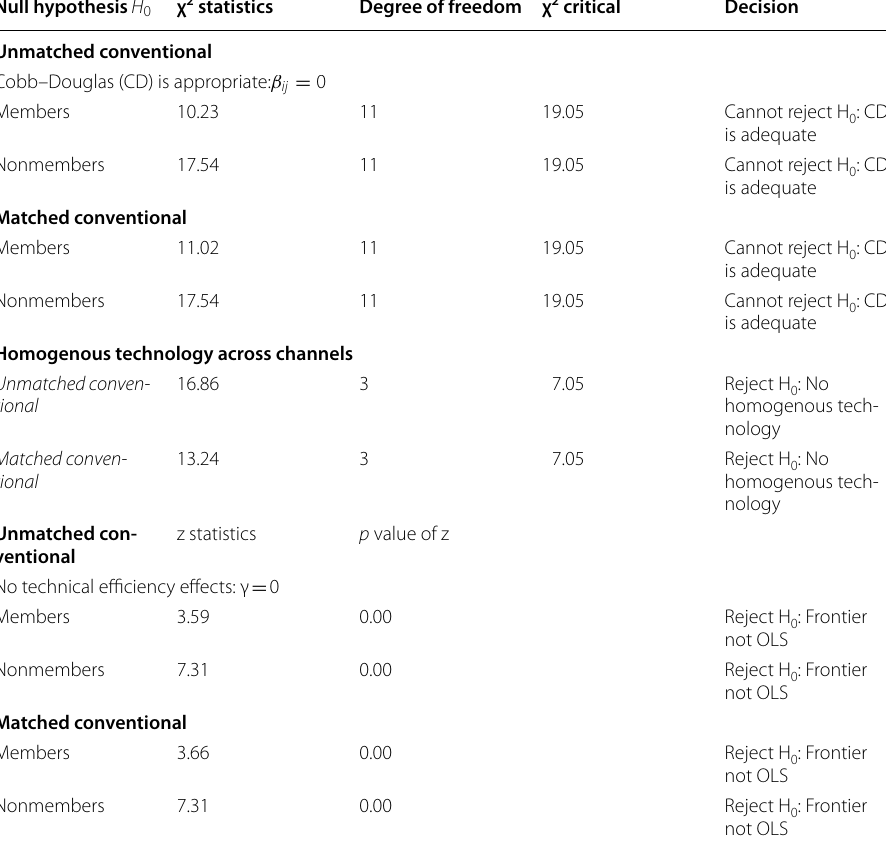
Table 11 Hypothesis testing for SPF